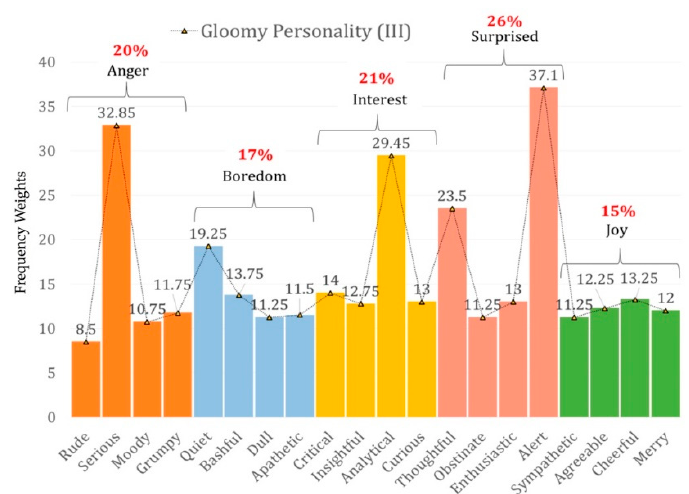
Figure 7. Gloomy Personality (Factor III): behaviors at Level 3.